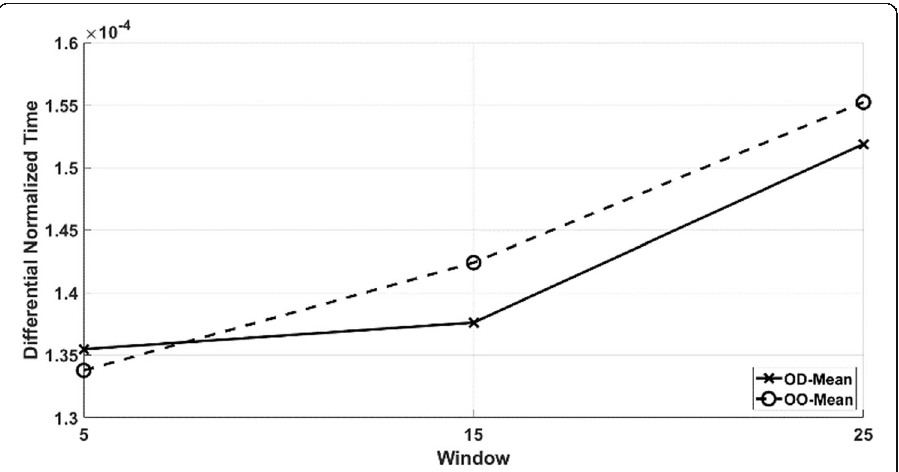
Fig. 3 Normalized mean time elapsed for OD and OO synchronization